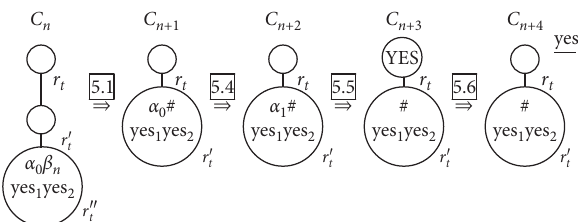
Figure 3: Affirmative answer. With rules from 4 and 5, an object yes is sent to the environment in the last step of the